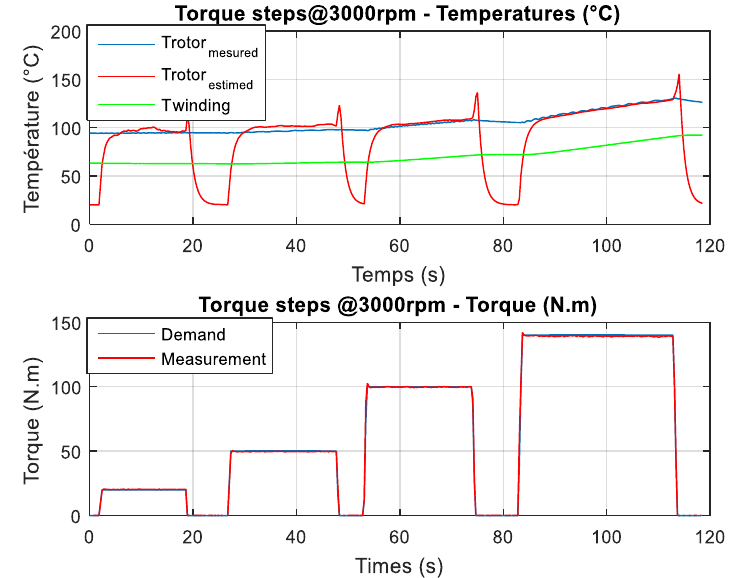
Figure 10. Comparison of temperatures found by estimator against pyrometer and torques at 3000 rpm and various torque-steps tests.